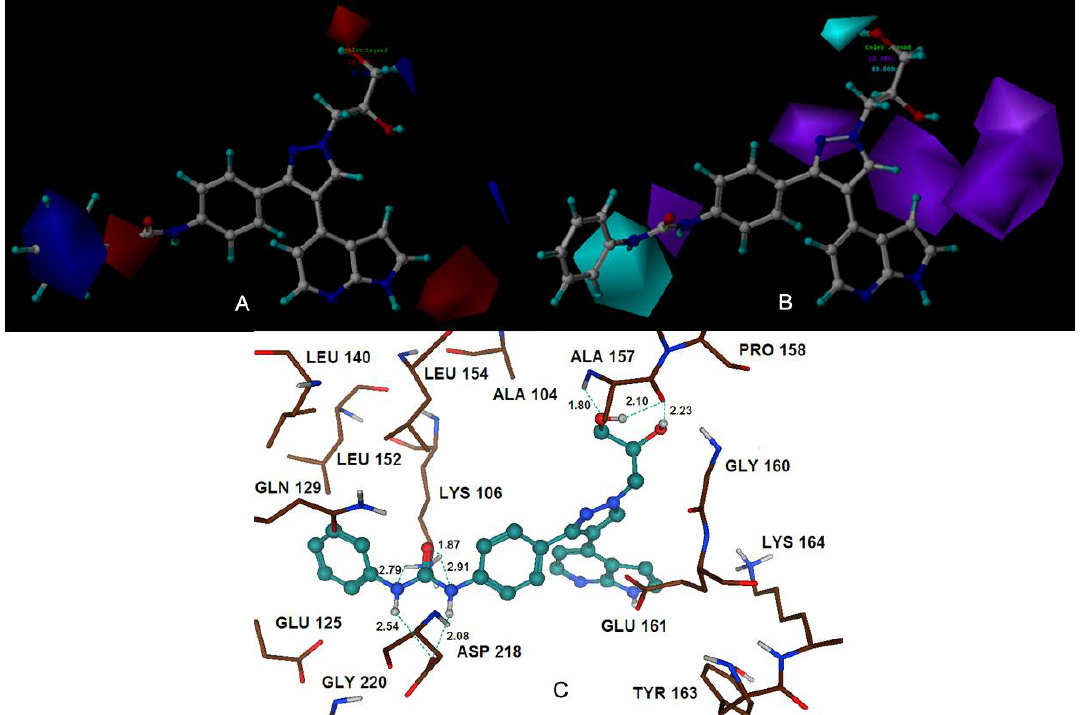
Figure 4. CoMSIA StDev*Coeff contour plots for GSK1070916. ( A ) The electrostatic contour map (red/blue) represents respective 80% and 20% level contribution combined with compound 40. Red contours indicate regions where negative charged substituents increase activity; blue contours indicate regions where positive charged substituents increase activity; ( B ) The hydrogen-bond donor (cyan/purple) contour map represents respective 80% and 20% level contribution combined with compound 40. Cyan contours indicate regions where hydrogen-bond-donor favorable substituents increase activity; purple contours indicate regions where hydrogen-bond-donor unfavorable substituents decrease activity; ( C ) The enlargement for stereoview of the docking structure of compound 40 in complex to the active site of the monomer structure of the Aurora B. Hydrogen bonds are shown as dotted green lines. Active site amino acid residues are represented as sticks, while the inhibitor is shown as ball and stick